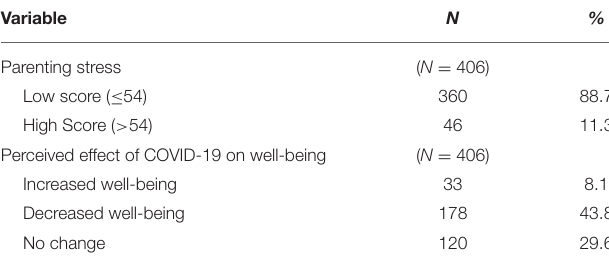
TABLE 2 | Parenting stress and well-being of eligible survey completers.